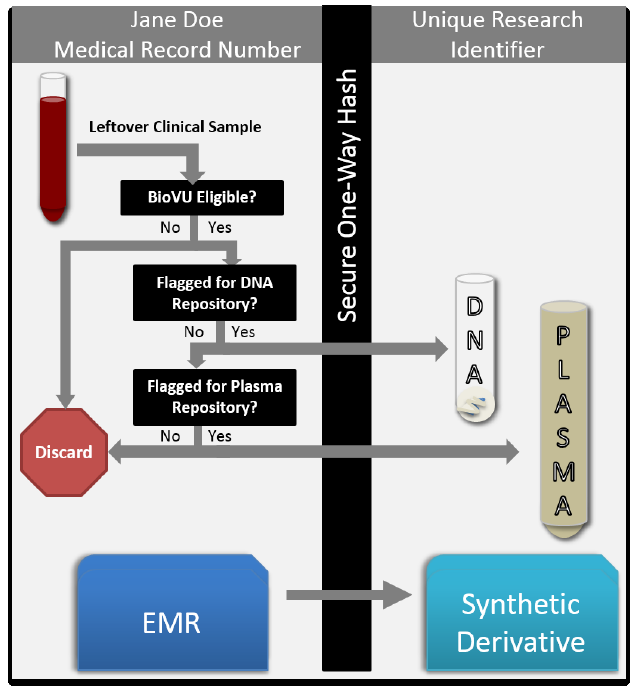
Figure 1. BioVU plasma biobanking is supported by existing DNA and EMR de-identification infrastructure. Leftover blood samples are scanned and queried against a database for BioVU DNA biobanking eligibility. Should DNA be already banked, the sample is considered for phenotypic plasma extraction. Both DNA and plasma are linked to their EMR through scrubbing by a secure one-way hash algorithm. Samples and records are linked via a de-identified research